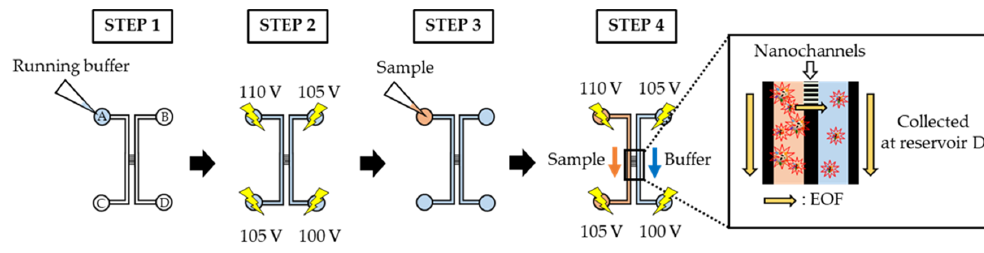
Figure 3. Protocols for the size sorting of exosomes. Table 1. Experimental conditions of the electrokinetic transportation of exosomes, and the size measurement condition.